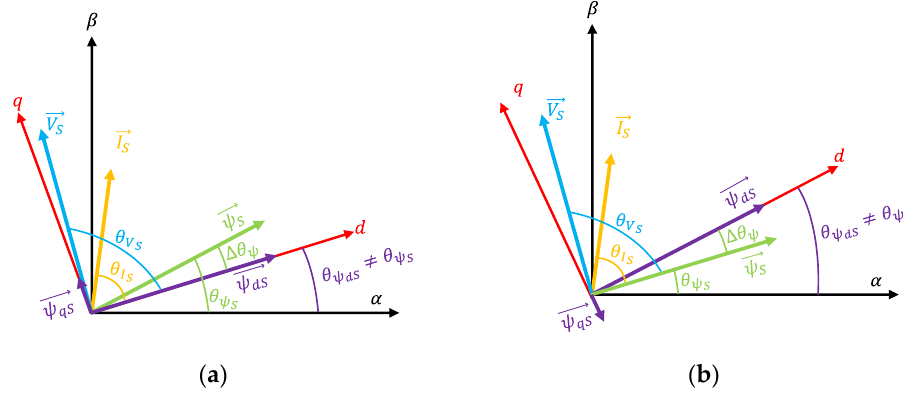
Figure 9. Misalignment in the stator flux: ( a ) d -axis lagging behind; ( b ) d -axis ahead.